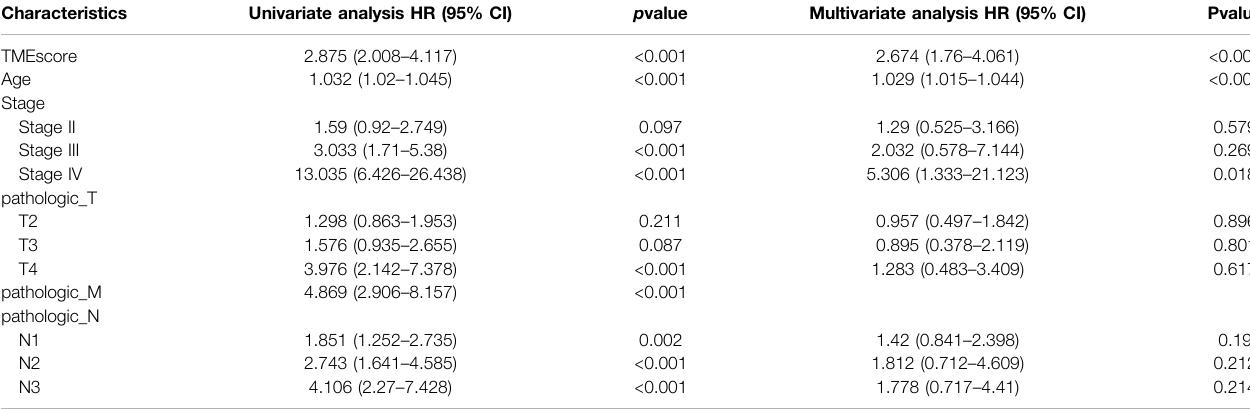
TABLE 1 | Univariate and multivariate analyses of clinicopathological characteristics and TMEscore with overall survival in TCGA BRCA cohort.